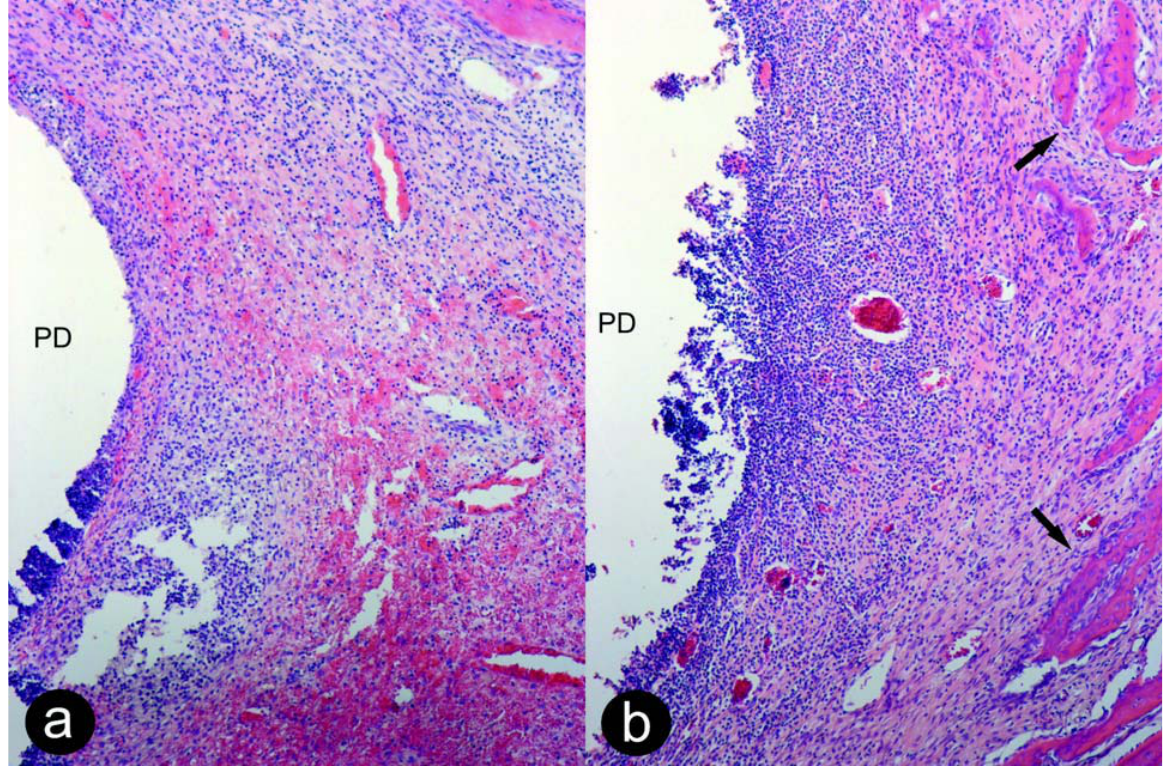
FIGURE 5- This image shows the behavior of Group IV at 7 days (a) and 28 days (b) close to the periodontal dressing (PD). The arrows indicate bone tissue formation. HE, original magnification 100X